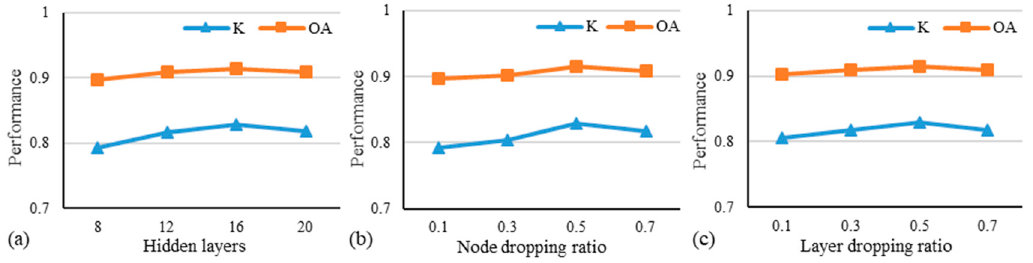
Figure 10. Influence of critical parameters: ( a ) Hidden layers, ( b ) Node dropping ratio, ( c ) Layer dropping ratio.